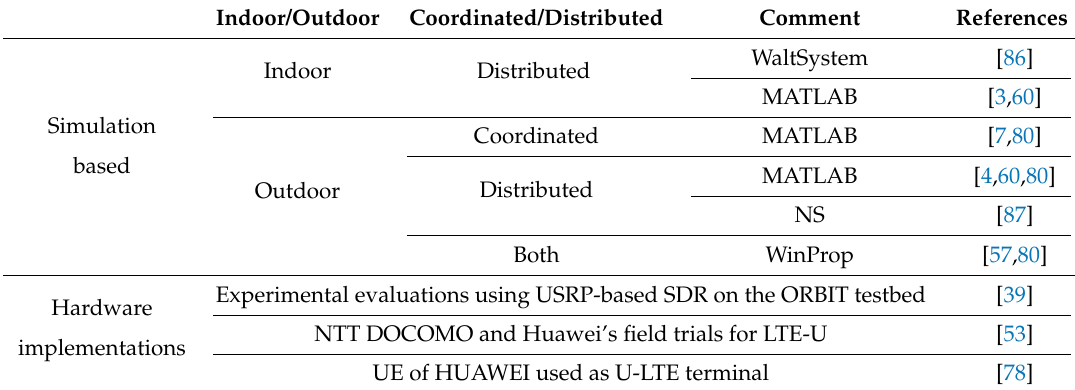
Table 3. A summary of evaluation environments considered for LTE-U performance